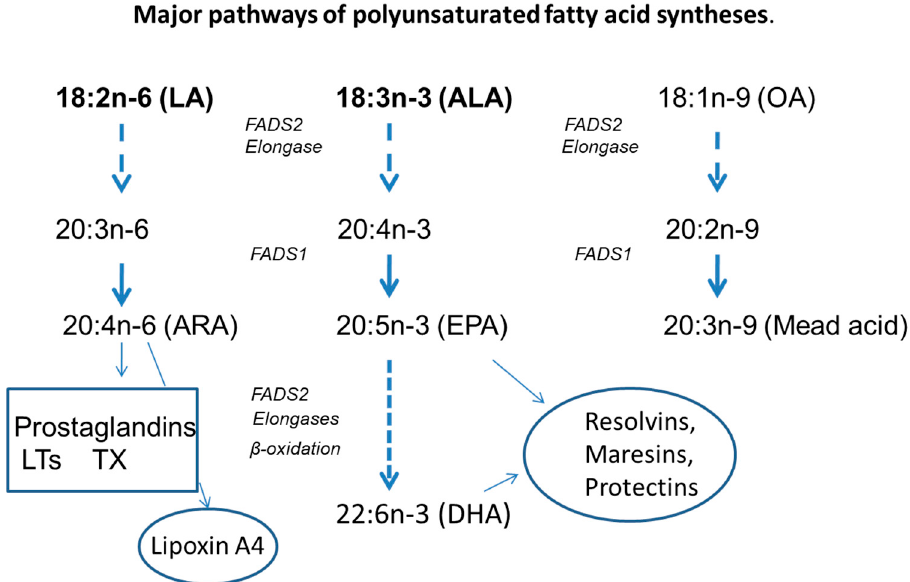
Figure 1. Major pathways of polyunsaturated fatty acid synthesis. Simplified major transformation steps to long-chain polyunsaturated fatty acids from the essential fatty acids, linoleic (LA) and α -linolenic (ALA) acids and the endogenously synthesized oleic acid (OA), which all compete for the same desaturases (FADS1 and FADS2) and elongases. The major metabolites are indicated in boxes, proinflammatory and ellipses (anti-inflammatory) lipid mediators. ARA, arachidonic acid;EPA, eicosapentaenoic acid; DHA, docosahexaenoic acid; LT, leukotrienes; TX, tromboxanes.